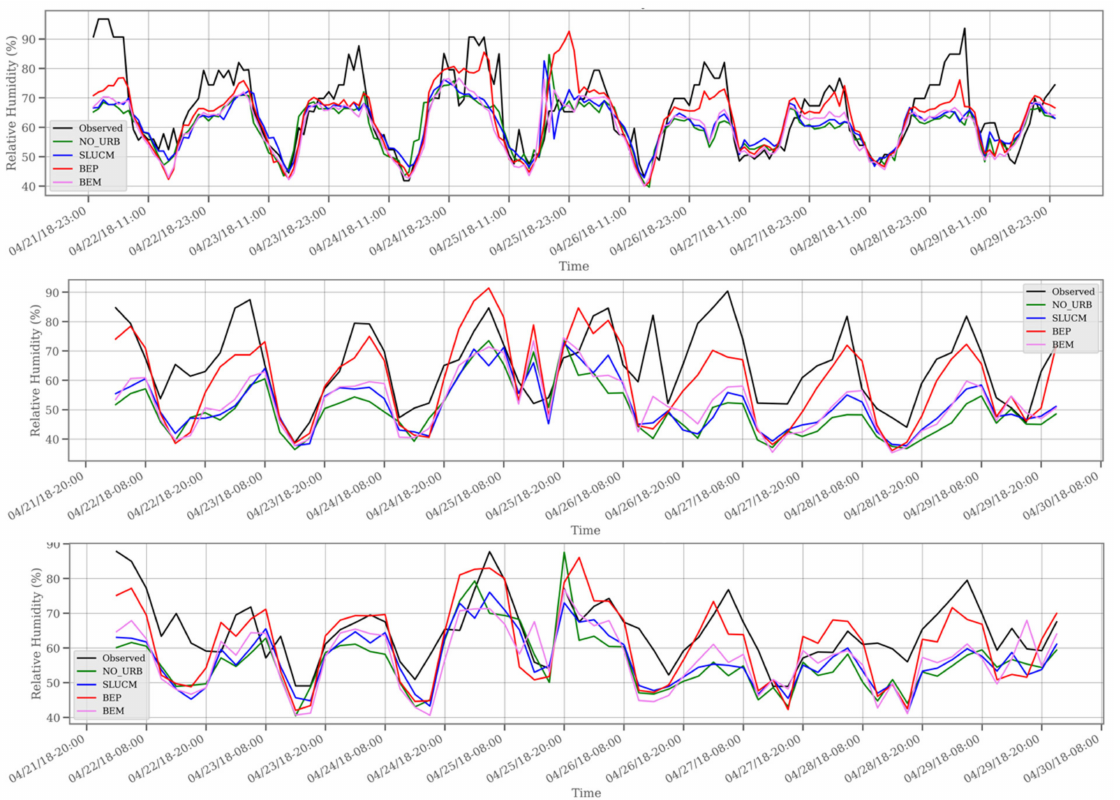
Figure 3. Temporal evolution of the observed and simulated relative humidity for NAIA ( top ), SGQ ( center ), and Manila Port ( bottom ). Simulation follows observed trend, although underestimations are predominantly observed for all design in all sites. BEP performs best among all